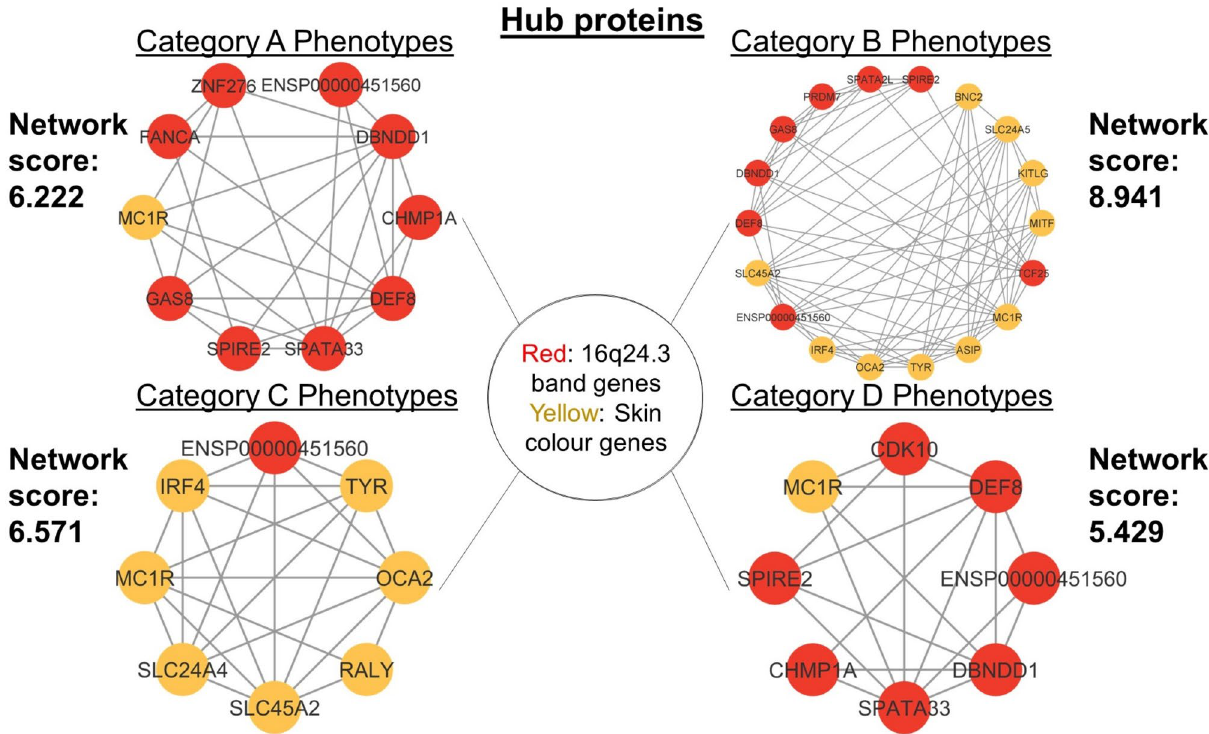
Figure 5. Network enrichment of skin ageing hub proteins. Only one strong network (i.e., Network score ≥ 4) is identified for each key skin ageing phenotype. Red gene nodes are genes on the chromosomal band 16q24.3 and yellow gene nodes are skin colour genes. Edges linking the node indicate evidence of enrichment between the two connected